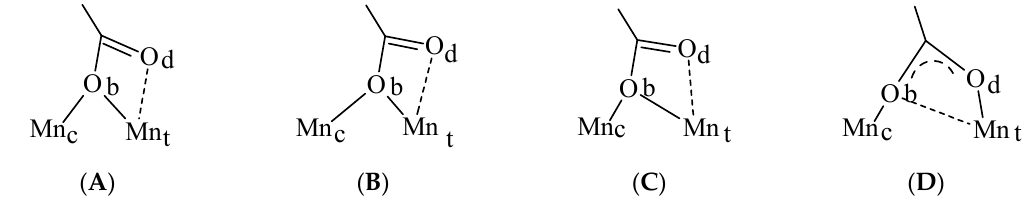
Figure 2. Carboxylate bridging mode in trinuclear complexes with the general formula Figure 2. [Mn 3 (RCOO) 6 (N–N) 2 ] [42].